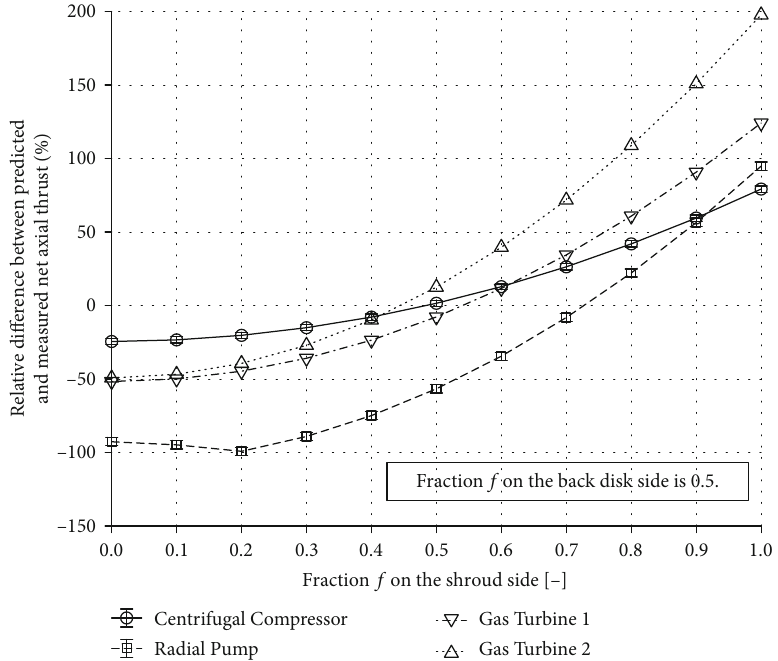
Figure 15: The sensitivity of the net axial thrust on the fraction on the shroud side when predicted by using the new hybrid